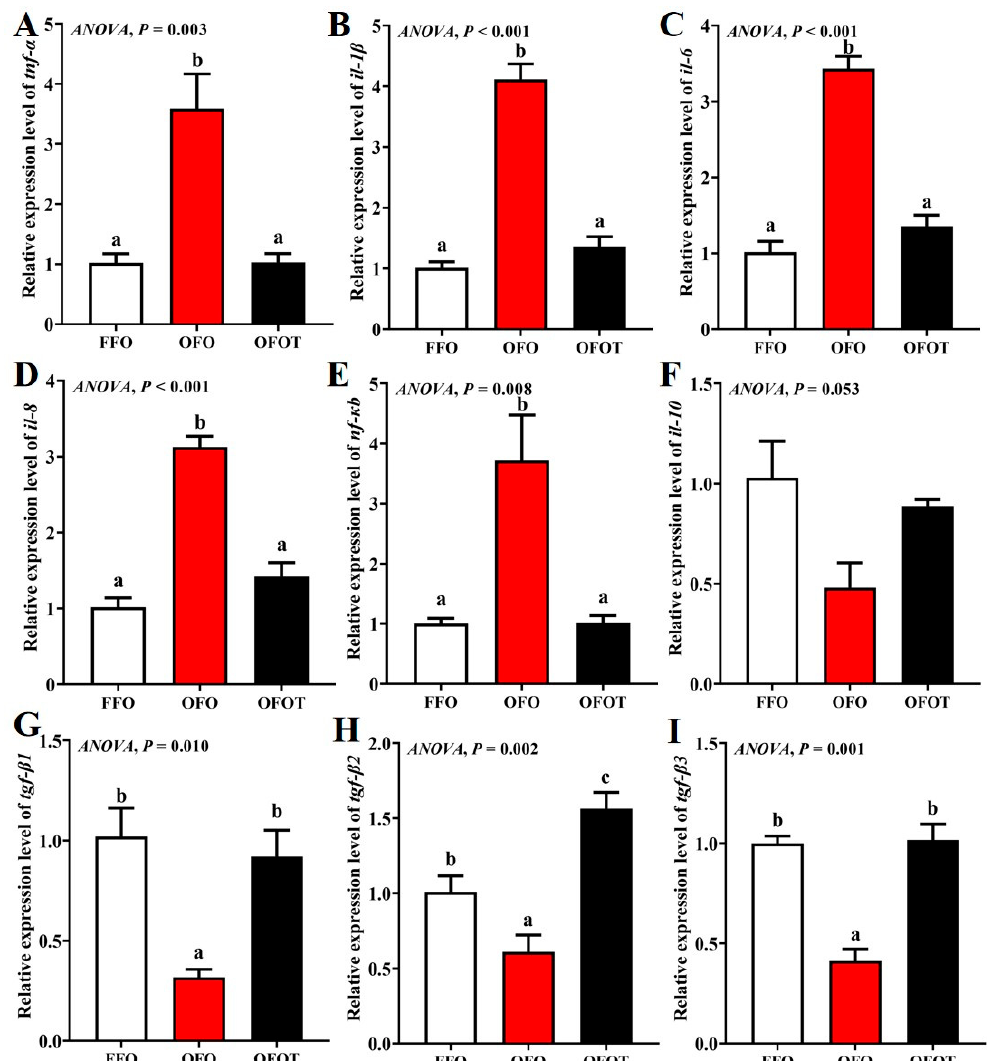
Figure 7. Effects of dietary taurine on intestinal immune-barrier-related genes expression of channel catfish ( Ictalurus punctatus ) fed oxidized-fish-oil diets. ( A ) tnf- α ; ( B ) il-1 β ; ( C ) il-6 ; ( D ) il-8 ; ( E ) nf- κ b ; ( F ) il-10 ; ( G ) tgf- β 1 ; ( H ) tgf- β 2 ; ( I ) tgf- β 3 . Data indicate the mean values of three replicate cages per treatment (three fish per replicate breeding barrel). Significance was evaluated by one-way ANOVA ( p < 0.05) followed by Duncan’s multiple range tests. Values marked with different letters are significantly different between the treatment groups.